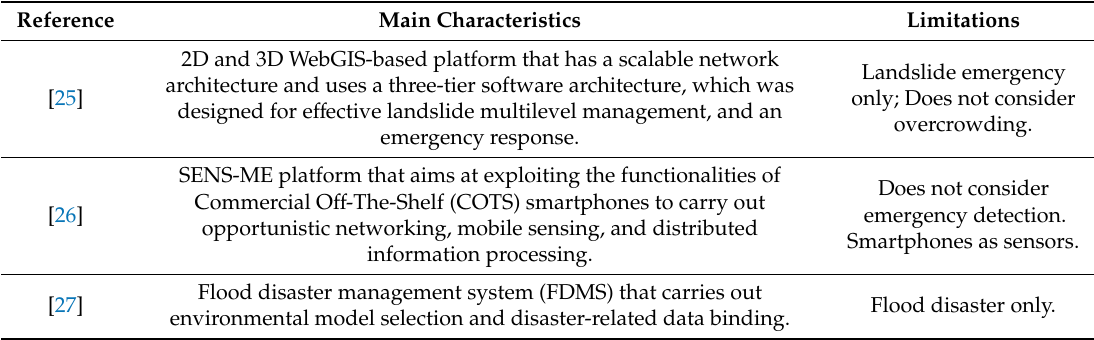
Table 2. Examples of platforms for emergency and disaster